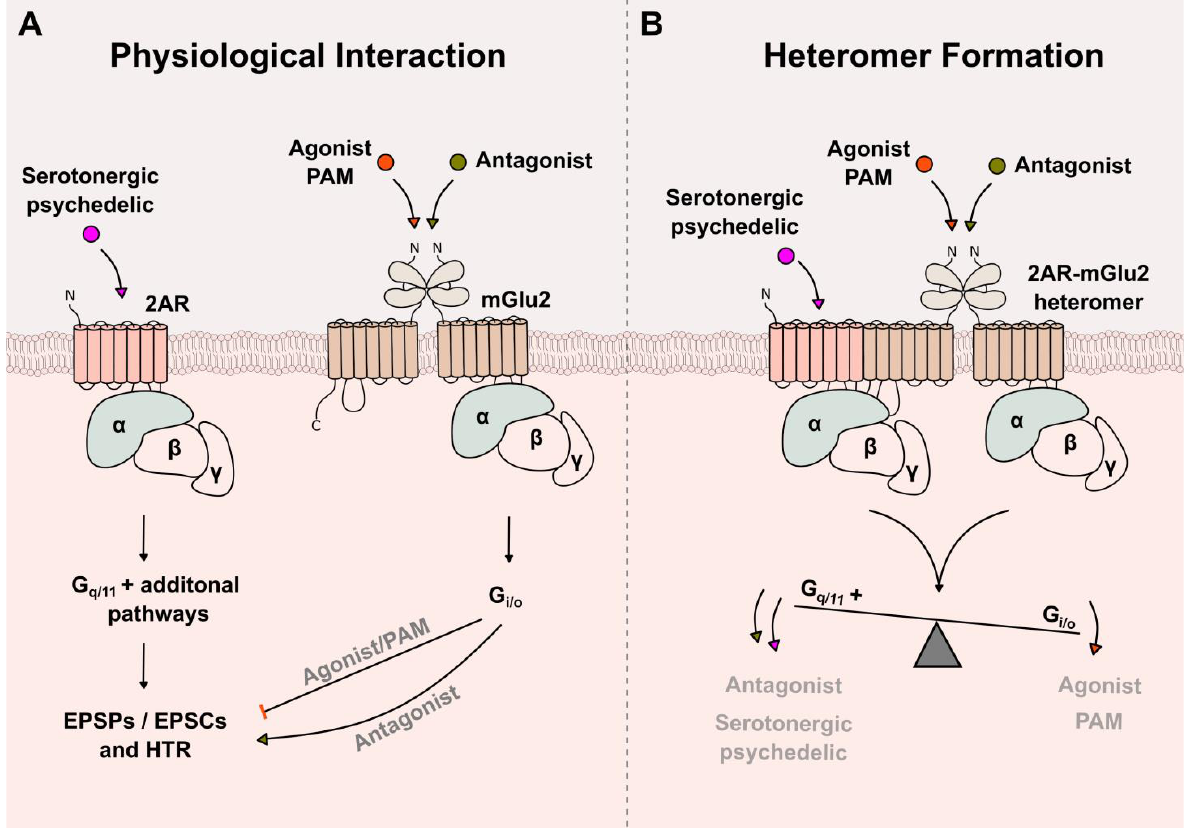
Figure 3. Cross-signaling of 2AR and mGlu2 through ( A ) physiological interaction and ( B ) the formation of a 2AR-mGlu2 heteromer. Activation of 2AR by serotonergic psychedelics induces EPSPs/EPSCs as well as psychedelic-related behaviors such as the HTR in rodents through the activation of G q/11 and additional signaling pathways (as described in Box 2). Stimulation of mGlu2 (by agonists or PAMs) or the presence of an mGlu2 antagonist was demonstrated to regulate these outcomes either ( A ) indirectly through its canonical G i/o signaling or ( B ) directly through the formation of a heteromer with 2AR. The heteromer is assumed to integrate both serotonergic and glutamatergic input (such as serotonergic psychedelics and mGlu2 agonists, and PAMs or antagonists) and shift the balance of G q/11 + (and additional signaling pathways) to G i/o signaling, accordingly. EPSC: Excitatory postsynaptic current, EPSP: Excitatory postsynaptic potential and PAM: Positive Allosteric